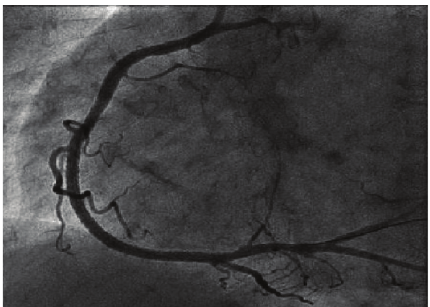
Figure 7: RCA after percutaneous coronary intervention and distal normal blood